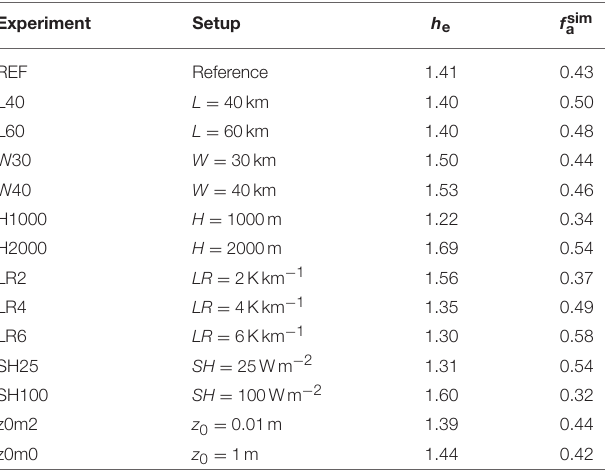
TABLE 1 | Summary of the numerical